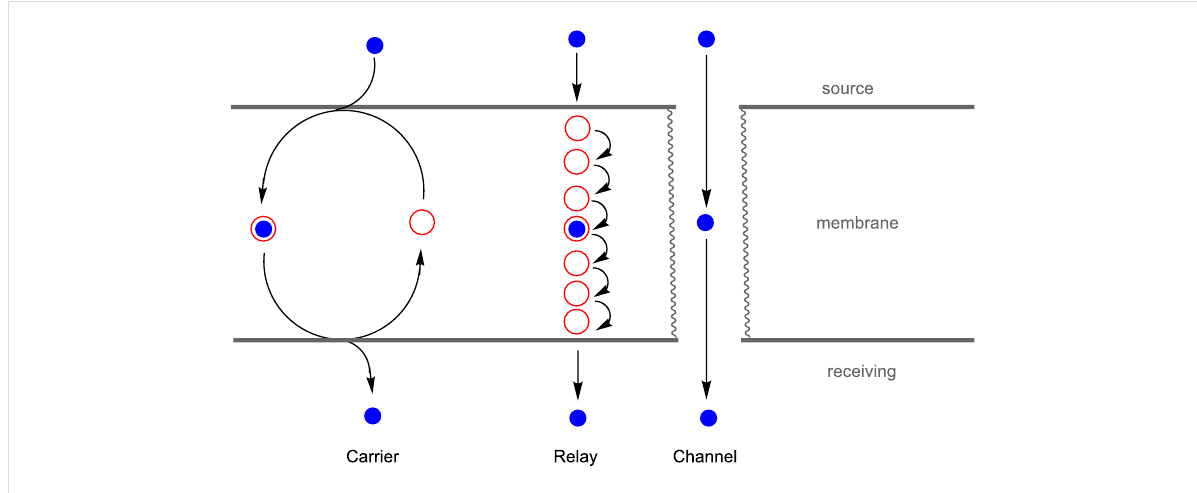
Scheme 2: Molecular transporters promote translocation of ions or hydrophilic biomolecules across a synthetic or biological membrane.